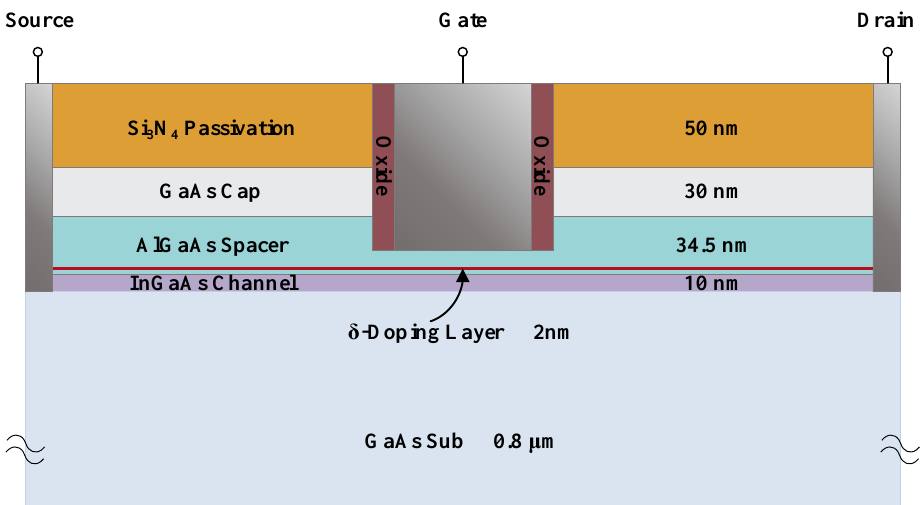
Figure 1. The basic structure of δ -doping AlGaAs/InGaAs pHEMT. The cross-section reveals the internal of the HEMT: from bottom to top, a 0.8 µ m GaAs substrate, a 10 nm InGaAs channel layer, a 34.5 nm AlGaAs spacer layer, and a 30 nm GaAs cap layer. The surface of the HEMT is passivated by 50 nm Si 3 N 4 and 0.1 µ m oxide. To make the heterojunction quantum well deeper to increase the electron concentration in the two-dimensional electron gas (2EDG), a 2 nm δ -doping layer is also added to the AlGaAs spacer layer. In addition, the gate length is 0.25 µ m, the Schottky barrier height is 0.9 eV, and the mole fractions of Al x Ga 1 − x As and In 1 − y Ga y As are 0.30 and 0.75, respectively. The DC characteristics of the device are analyzed in Figure 2, which demonstrates the accuracy and reliability of the device model.